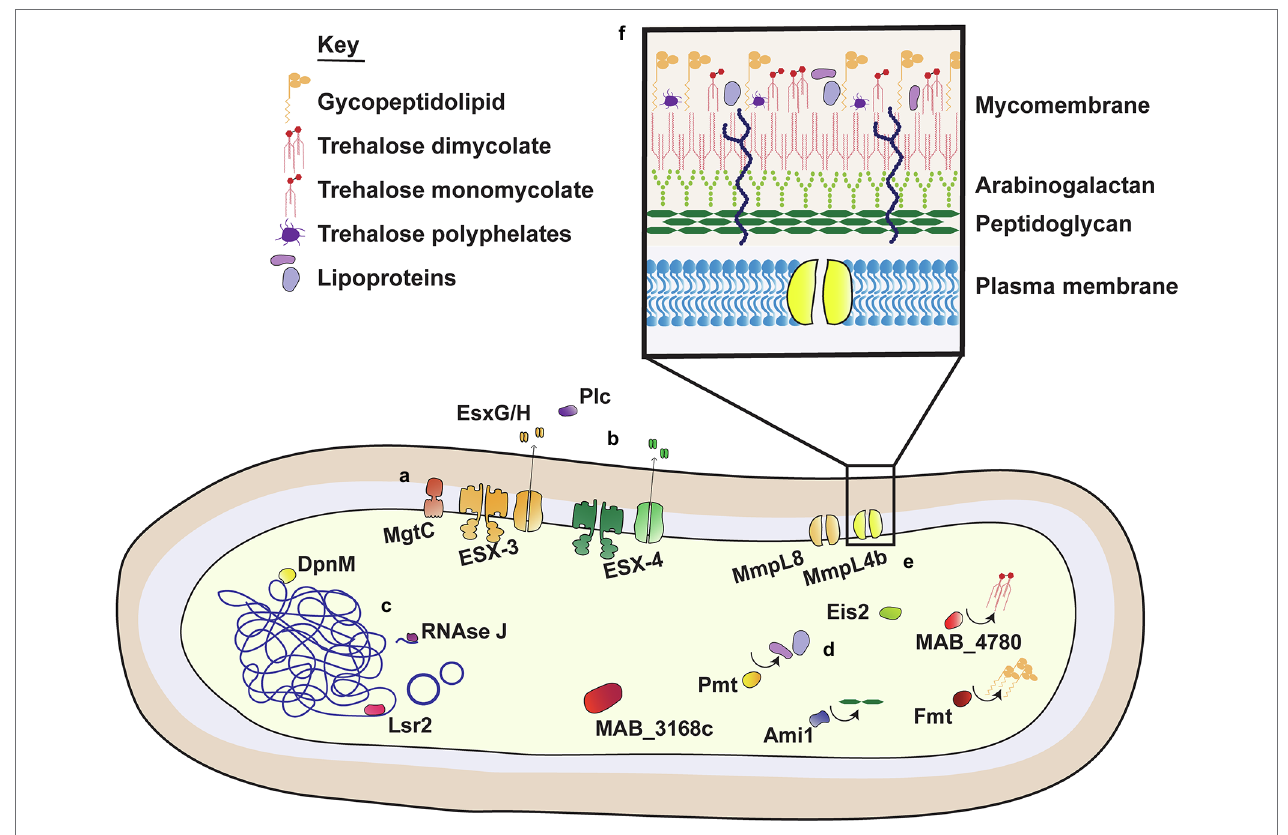
FIGURE 1 | Virulence factors of M. abscessus . M. abscessus uses an extensive range of virulence factors to facilitate survival within host cells. These include membrane bound proteins, pores and secretion systems (i); secreted proteins with a role in virulence (ii); transcriptional regulators and nucleic acid associated proteins (iii); proteins involved in the modification (iv) and transport (v) of cell surface components; and molecules that comprise the outer mycobacterial membrane